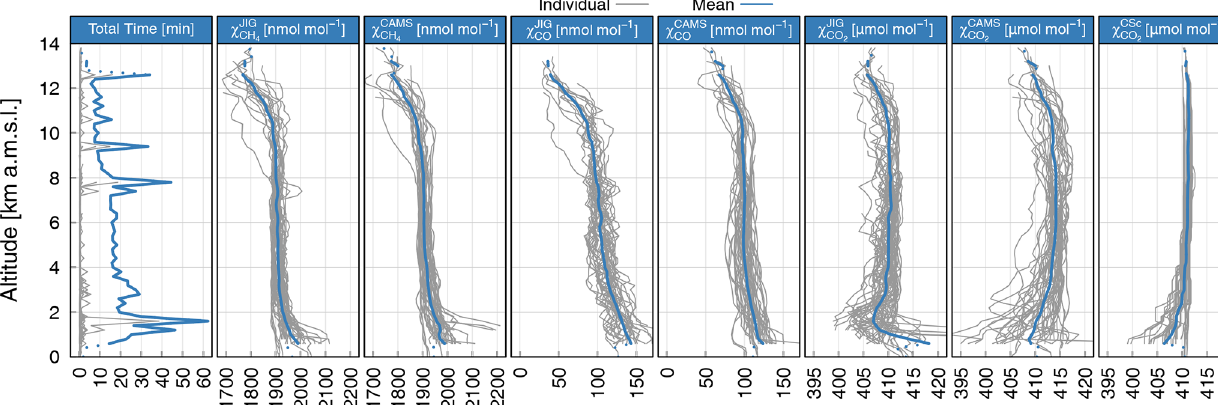
Figure 5. An overview of the vertical profiles measured during the CoMet 1.0 mission, together with modelled profiles from CAMS and CarboScope (denoted with CSc). In the first panel, total time is calculated as a sum of 1s observations from each respective bin. All the other panels present mole fractions for different variables, binned into 200m layers. Averages for each layer are shown as a solid blue line, while solid grey lines represent individual profiles. Dashed lines represent the means with less than 200s of observations available. Only data from the individual profiles marked on Fig. 2 are plotted here; i.e. the measurements collected during horizontal sections of the flights are not included.